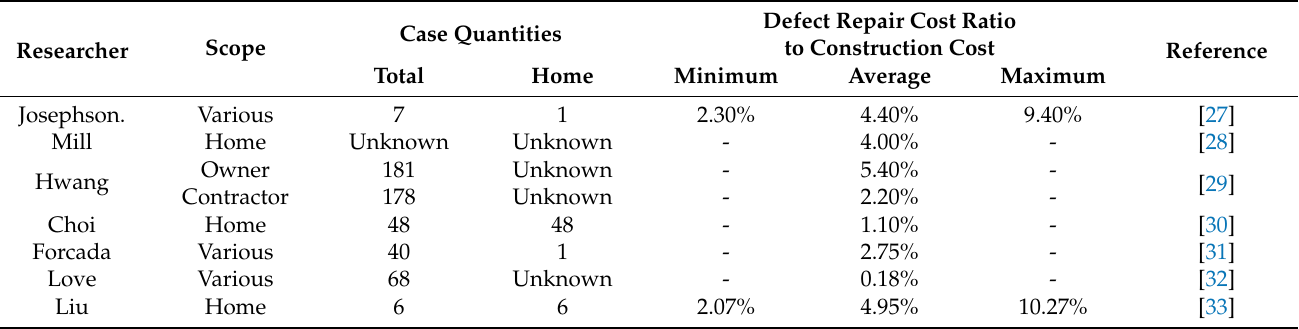
Table 1. Comparison of DRC ratio to CC in previous